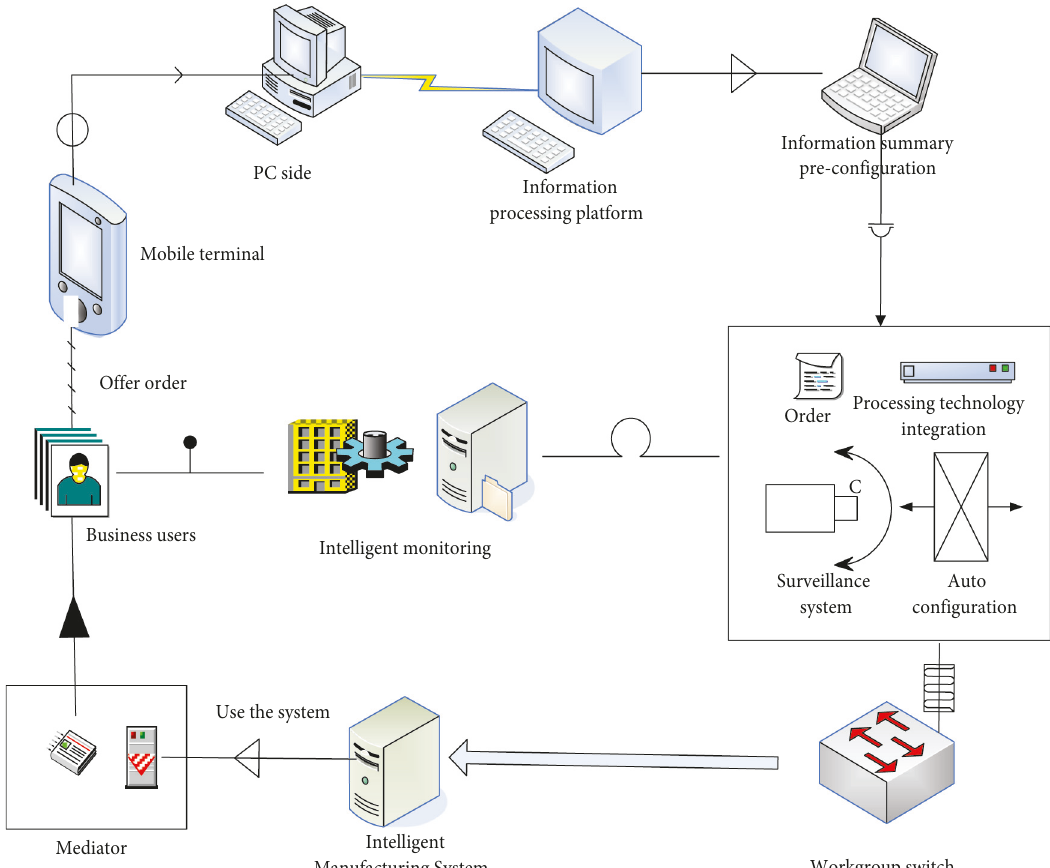
Figure 3: Intelligent manufacturing structure